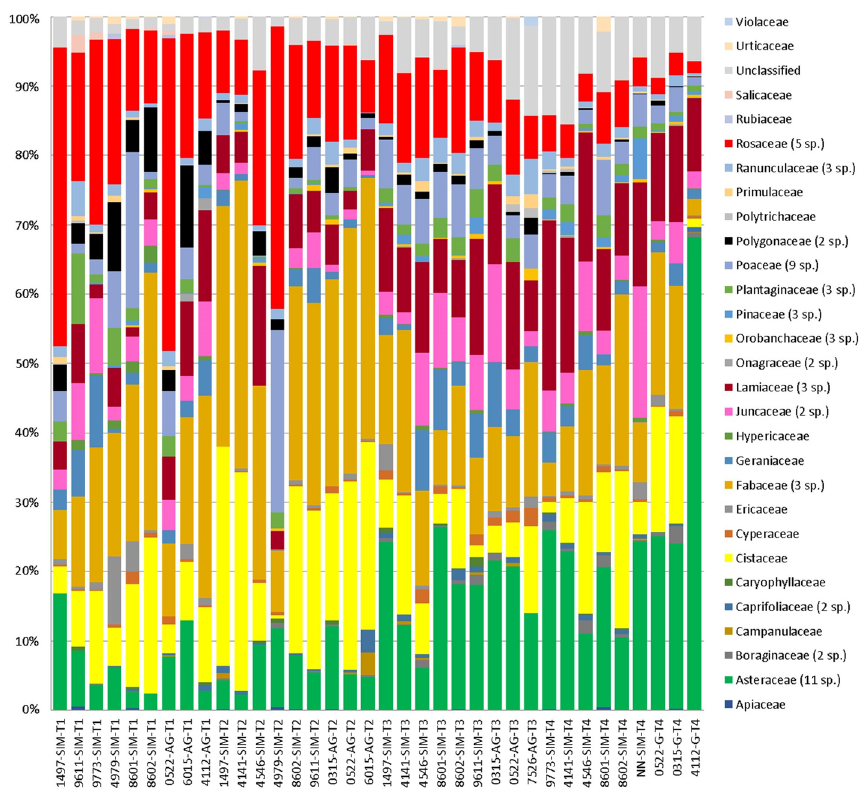
Figure 1. Clustered bar chart of the relative percent abundance showing the substitutional shifts of the plant taxa, grouped at family level, identified by DNA sequencing from bovine fecal material. The number of species featured by families in which more than one taxon was found is indicated in brackets. Samples belonging to the four time points (T1 trough T4) are ordered from left to right and coded by cow individual numbers and breed (SIM: Simmental; AG: Alpine